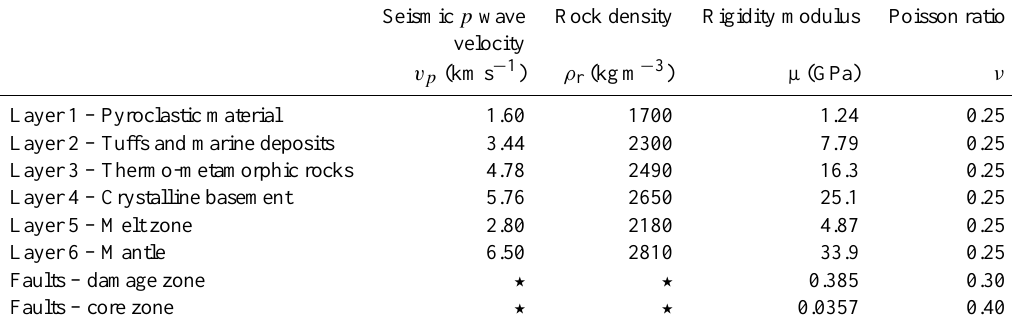
Table 2. Mechanical parameters for the domain of Fig. 3: seismic p wave velocity v p (kms − 1 ), rock density ρ r (kgm − 3 ), rigidity modulus µ (GPa), Poisson ratio ν